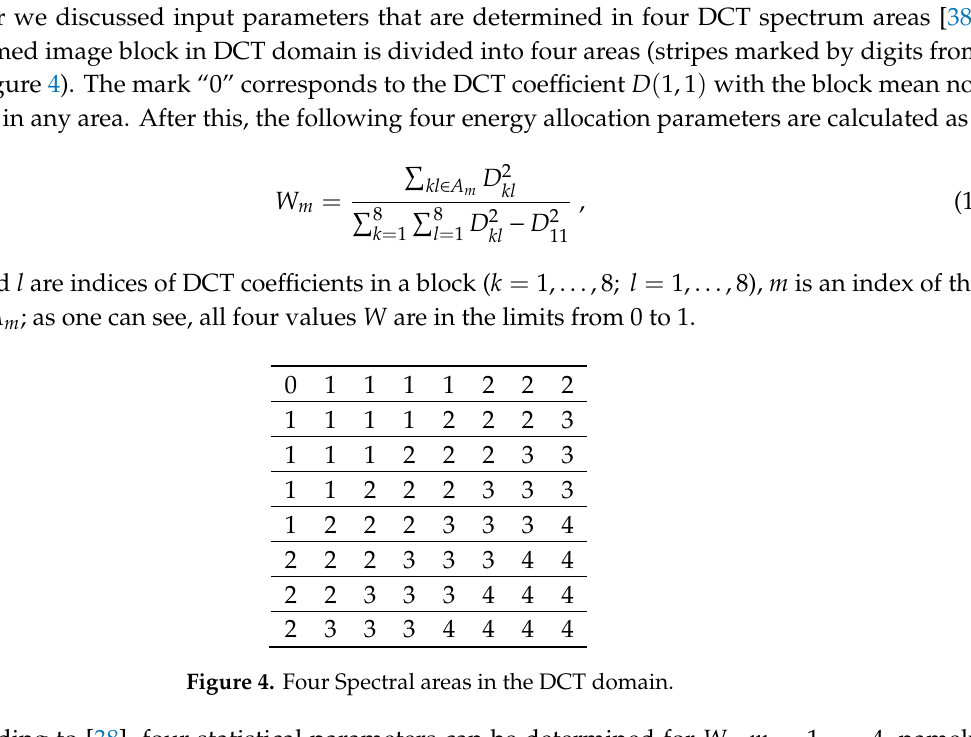
Figure 3. Noise-free ( a ), noisy ( b ) and filtered ( c ) images; normalized DCT spectrum for simulated images ( d ).